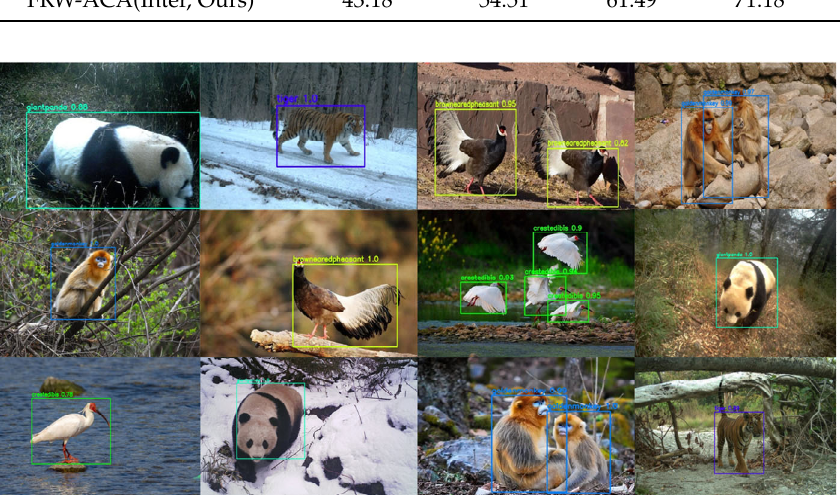
Figure 6. Detection samples of our 10-shot detection on endangered animals, including bounding boxes, categories, and confidence scores.